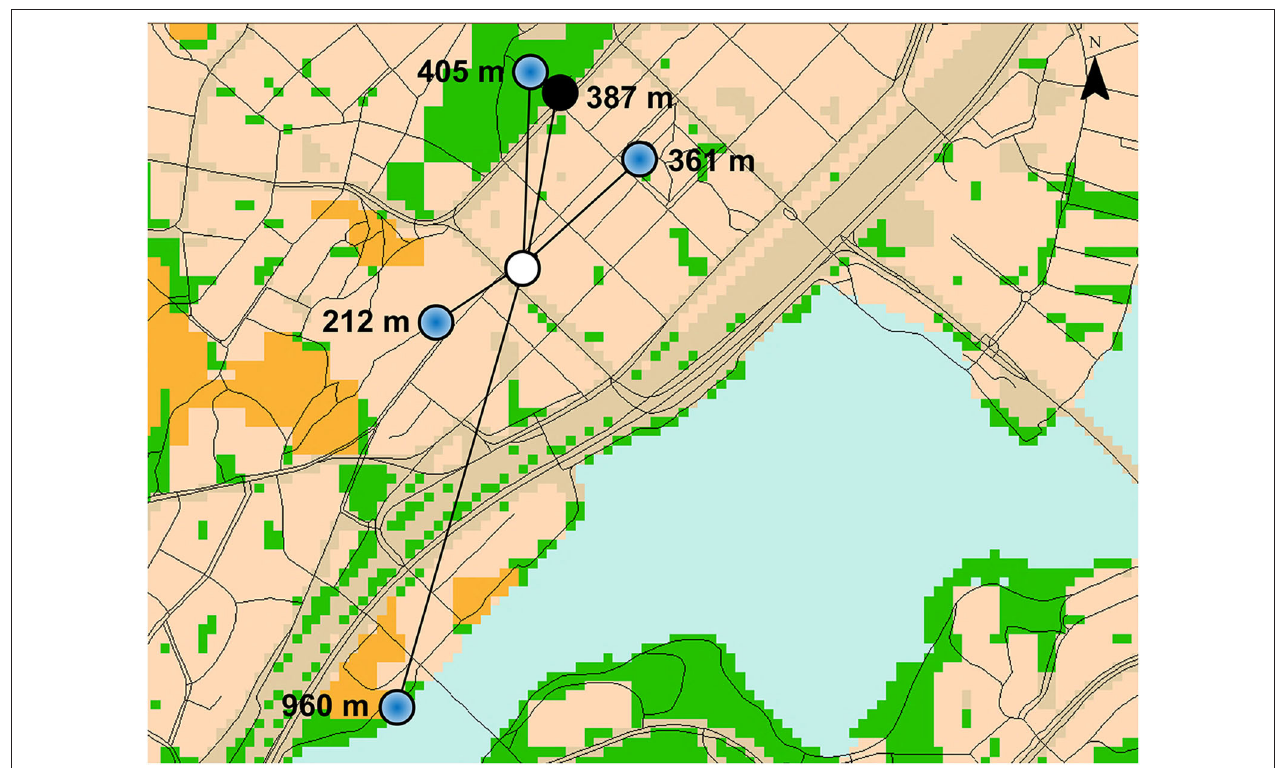
FIGURE 1 | Visualization of the Euclidean distance from the home (white open circle) of a fictive participant to reported destinations (blue dot) and barriers (black dot) for outdoor mobility located on a map [geographical datasets used (30,